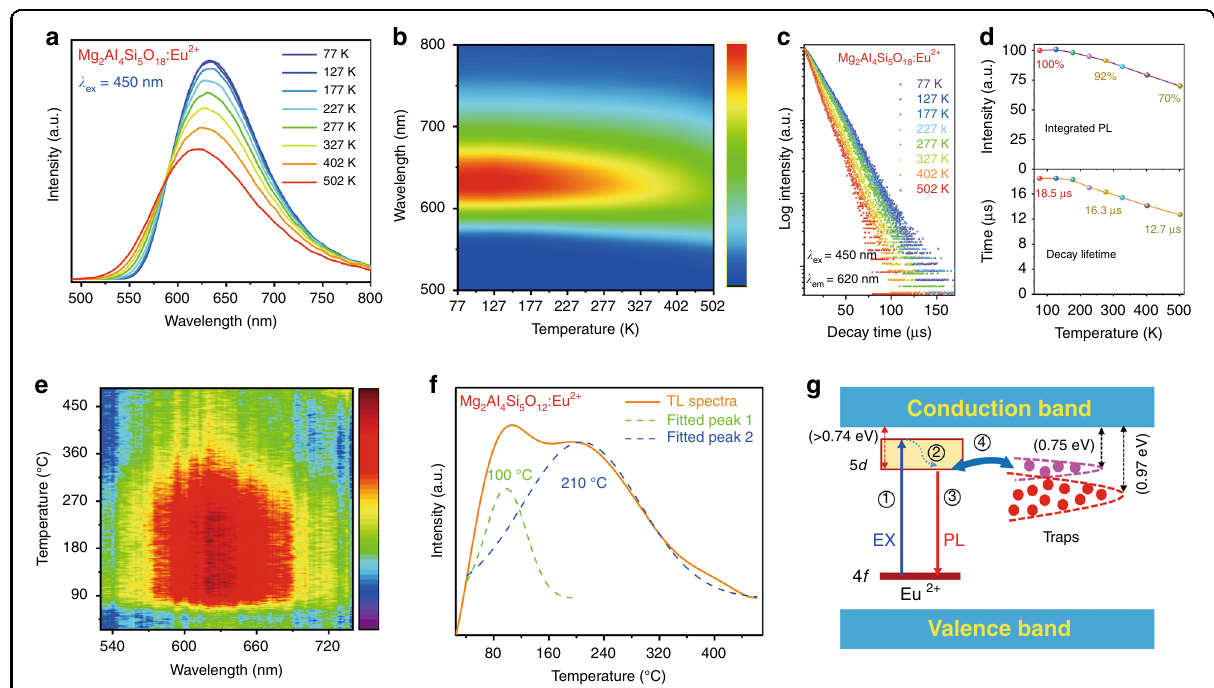
Fig. 4 Thermal emission properties of the Mg 2 Al 4 Si 5 O 18 :Eu 2 + composite phosphor. a , b Emission spectra of Mg 2 Al 4 Si 5 O 18 :Eu 2 + ( λ ex = 450 nm) in the temperature range 77 – 502 K. c Decay curves of Mg 2 Al 4 Si 5 O 18 :Eu 2 + ( λ ex = 450 nm, λ em = 620 nm) in the temperature range 77 – 502 K. d Normalized integrated PL intensity and decay time as function of temperature. TL glow curves of the Mg 2 Al 4 Si 5 O 18 :Eu 2 + composite phosphor, e three-dimensional TL f two-dimensional TL spectra. g Schematic illustration of the possible mechanism of the slow decay of Eu 2 + 5 d state in Mg 2 Al 4 Si 5 O 18 , showing the processes of electron ① excitation, ② nonradiative relaxation, ③ emission, ④ trapping, and